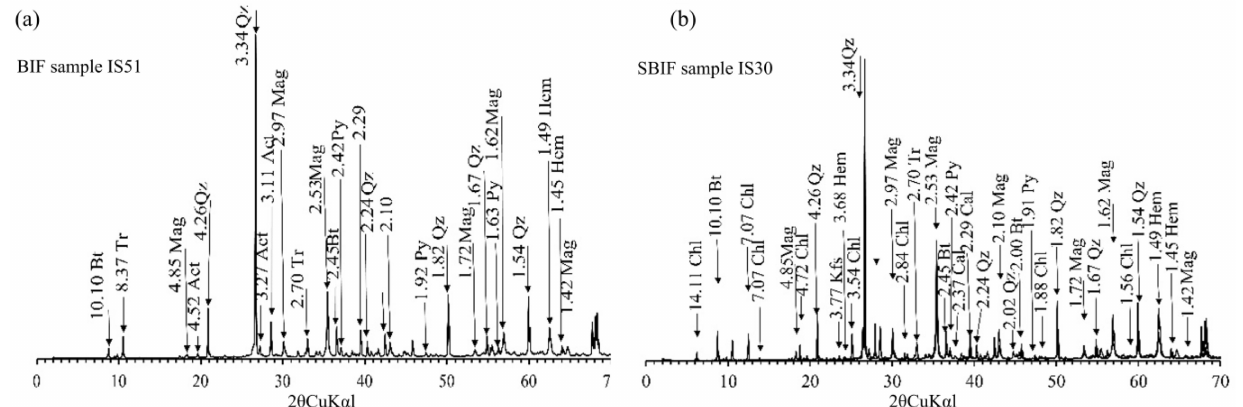
Figure 7. X-ray diffraction spectra for the Anyouzok BIF ( a ) and SBIF ( b ) samples, indicating prominent quartz and magnetite peaks. Magnetite (Mag), biotite (Bt), hematite (Hem), quartz (Qz), chlorite (Chl), tremolite (Tr), actinolite (Act), pyrite (Py), Calcite (Cal).